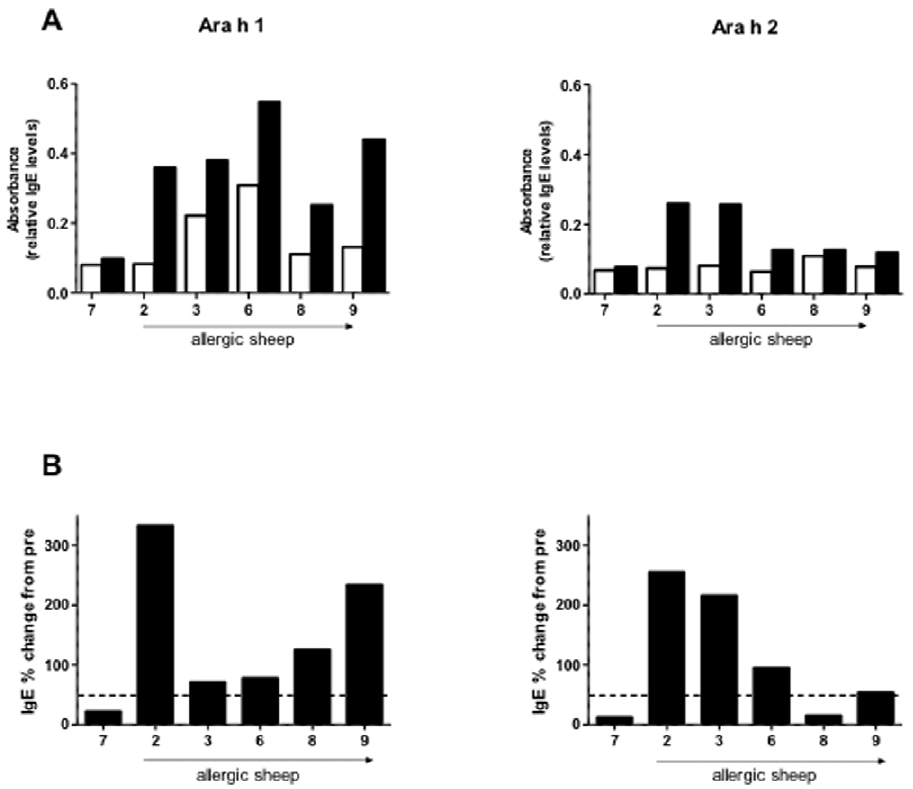
Figure 3. PN allergic sheep respond to the major peanut allergens Ara h 1 and Ara h 2. Blood serum collected before sensitisation (pre) and 7 days after the final (boost) injection of PN from allergic sheep (numbers 2, 3, 6, 8 and 9) and one non-responder (number 7) were tested for the presence of Ara h 1- and Ara h 2-specific IgE by ELISA. (A) Illustrates the individual differences between pre IgE (open bars) and day 7 post boost IgE levels (solid bars) whilst (B) shows the IgE percentage change from pre. Dashed line delineates greater than 50%